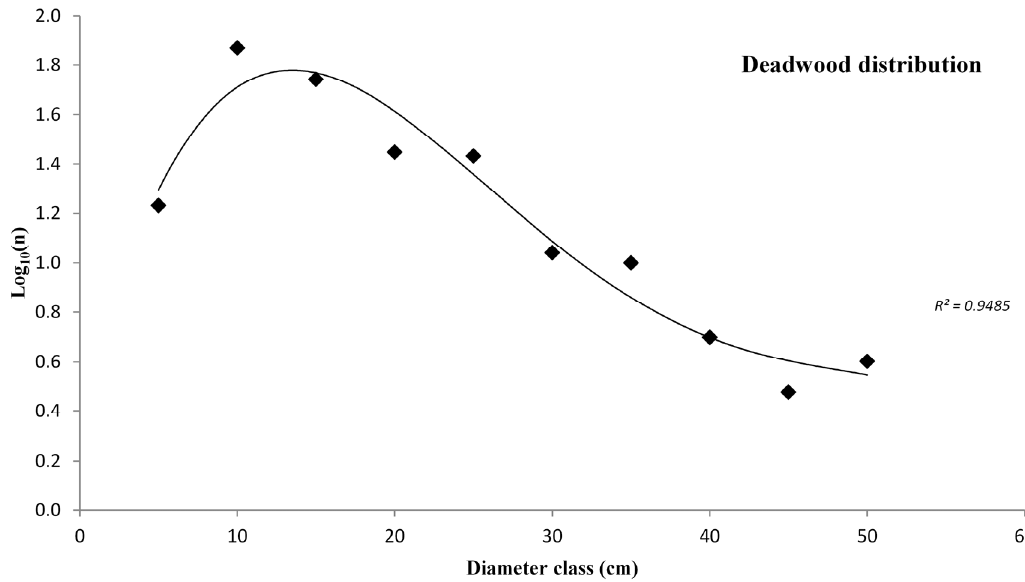
Figure 8. Total deadwood distribution according to mean diameter.